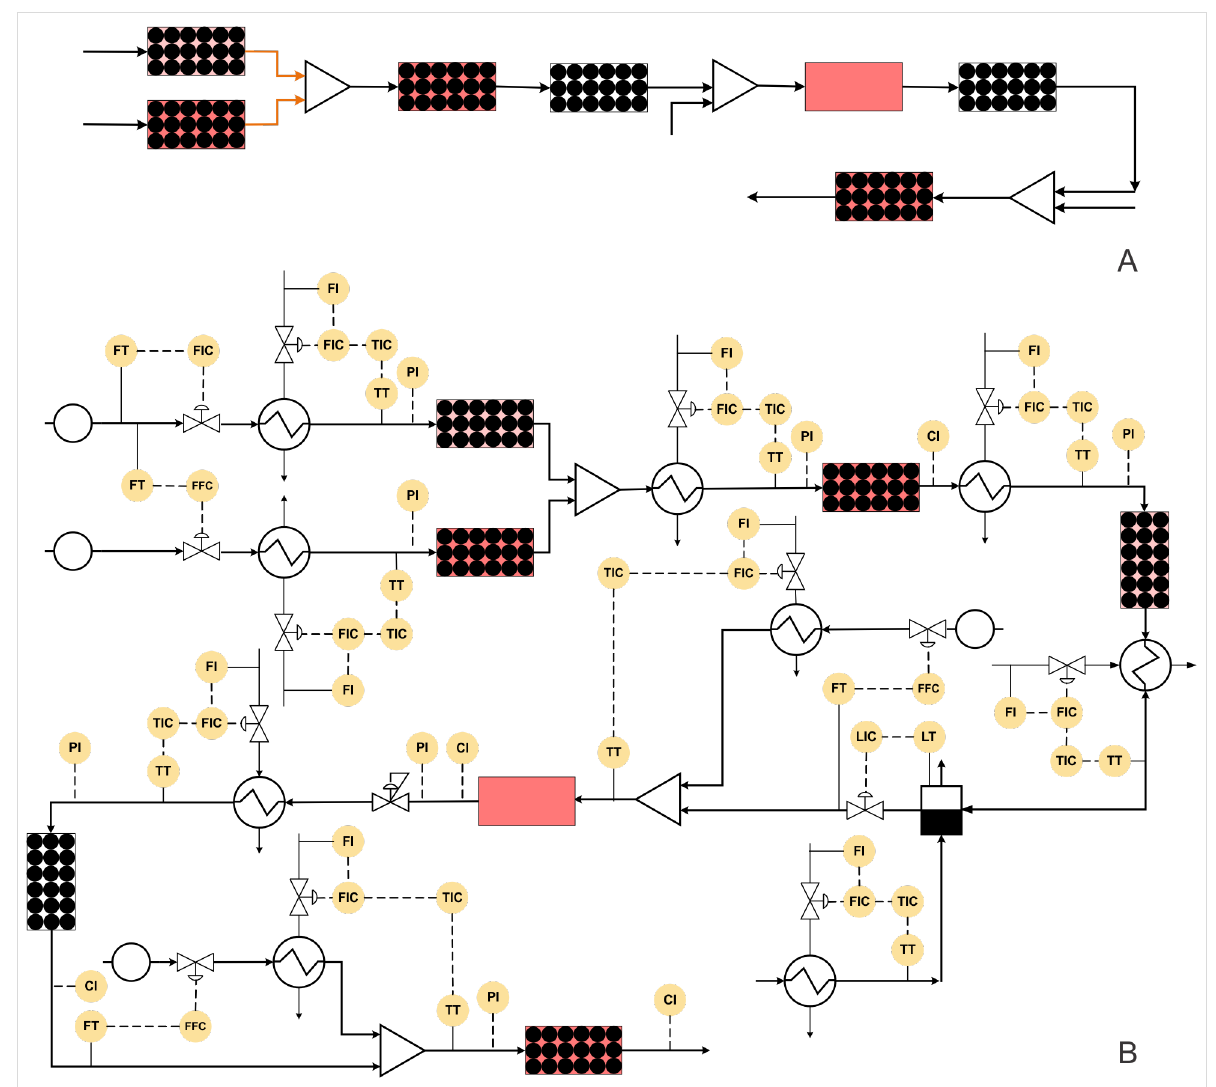
Figure 6: (A) Block diagram representation of the process shown in Scheme 4, (B) piping and instrumentation diagram of Scheme 4.